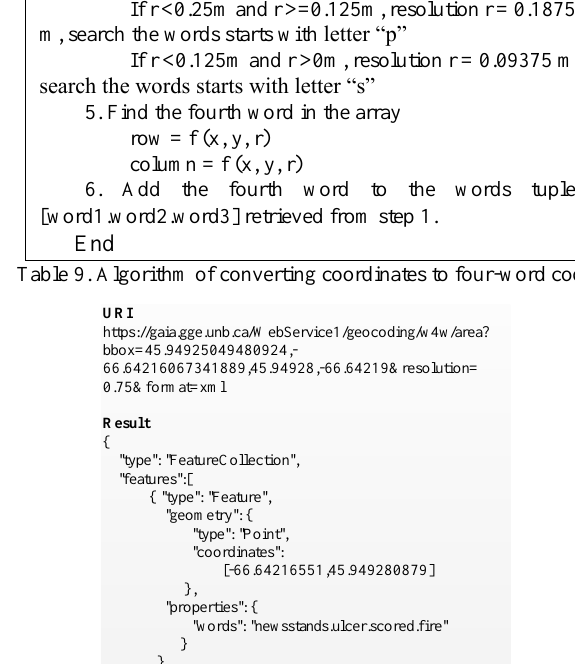
Figure 11. Encoding with four-word code